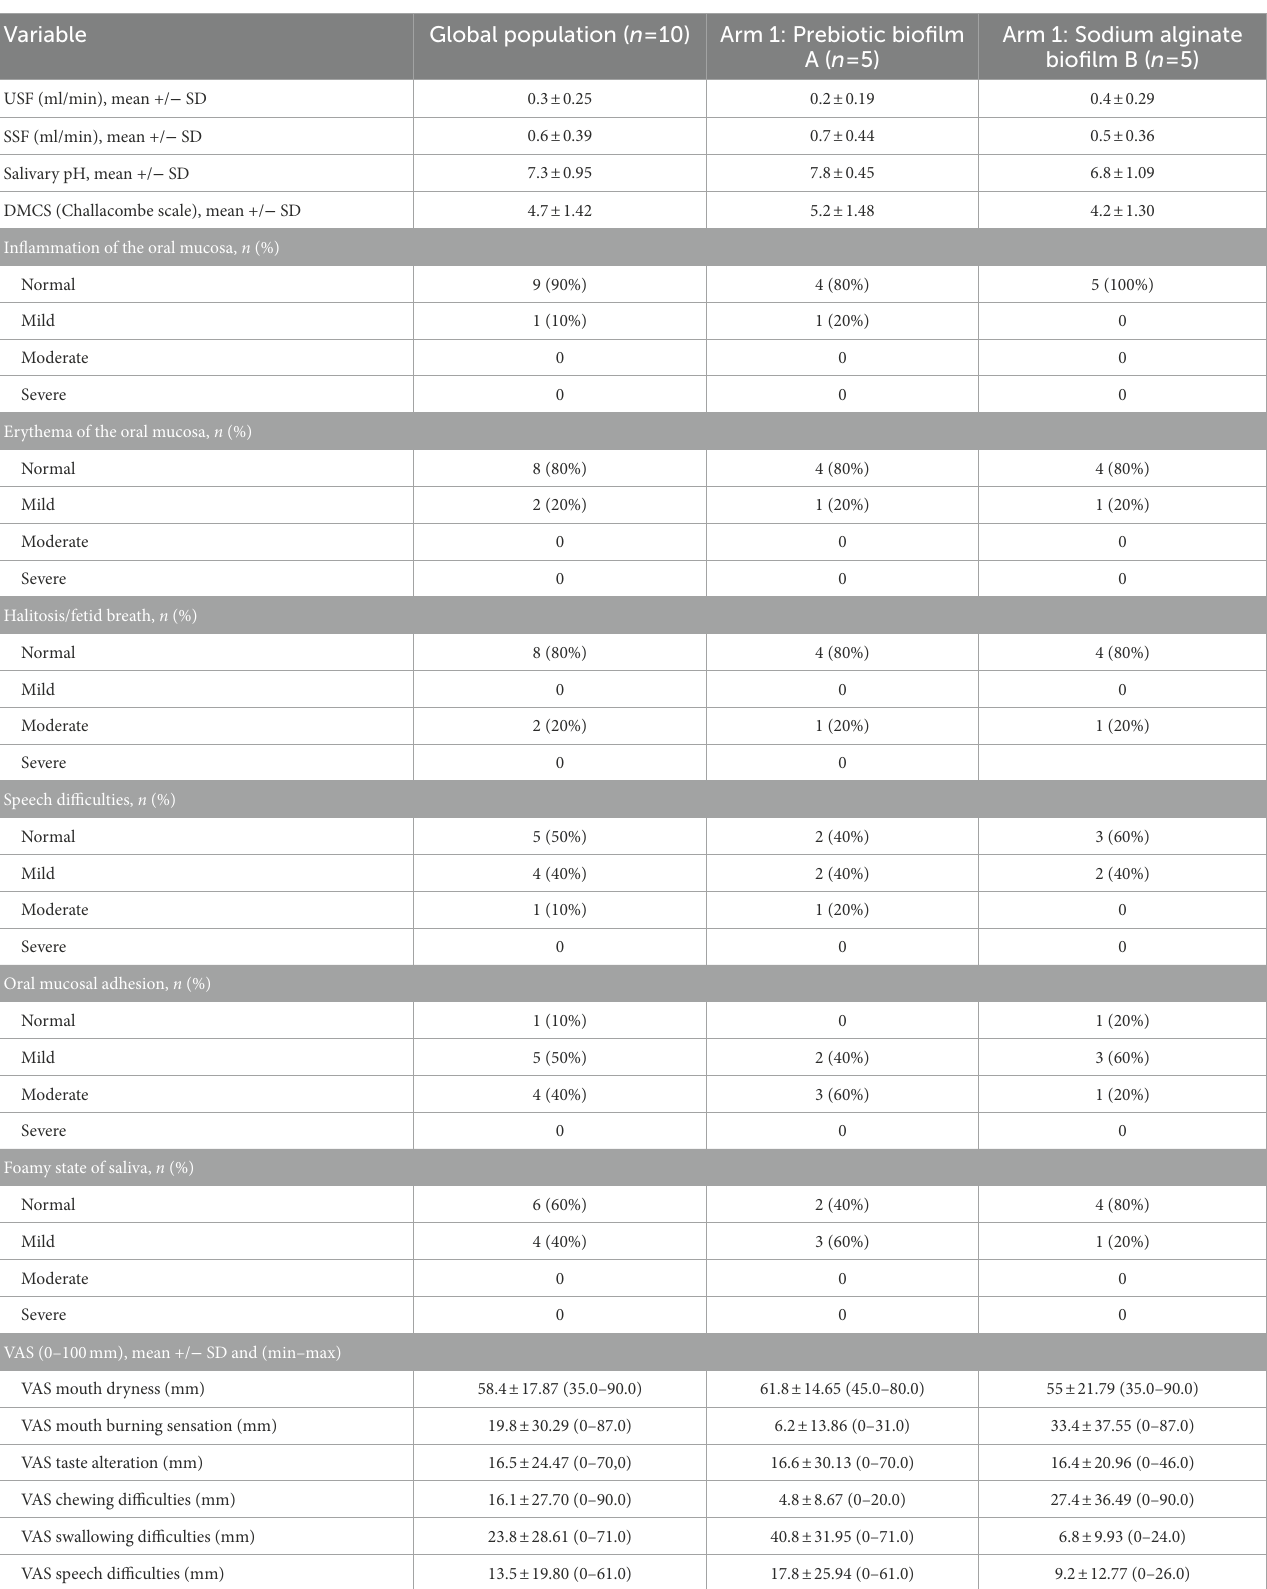
TABLE 2 Clinical parameters at inclusion (D0).